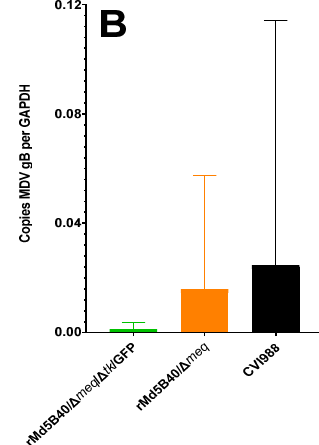
Figure 1. Ablation of the tk gene in MDV rMd5B40 attenuates replication both in vitro and in vivo. ( A ) When viral replication was assayed in vitro, the rMd5B40 ∆ meq/ ∆ tk /eGFP variant accumulated significantly less glycoprotein B transcripts than either the wild-type virus or the rMd5B40/ ∆ meq . ( B ) In vivo, the ∆ tk recombinant also trended towards less viremia 6 days after inoculation at day-of- hatch, but the differences between these groups and the rMd5B40/ ∆ meq parental were not statistically significant (data not shown). For panel A data were compared using unpaired t-tests, (***) indicates a statistically significant difference between groups. For B, data were compared using ordinary ANOVA